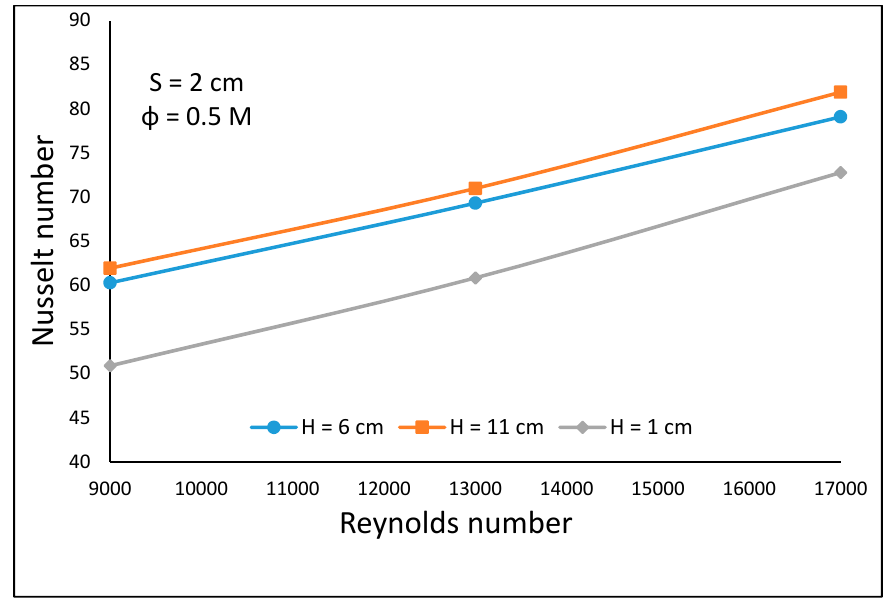
Figure 15. Interaction of Reynolds number and nozzle-plate distance levels at optimum levels of other factors at nozzle-nozzle spacing = 2 cm.